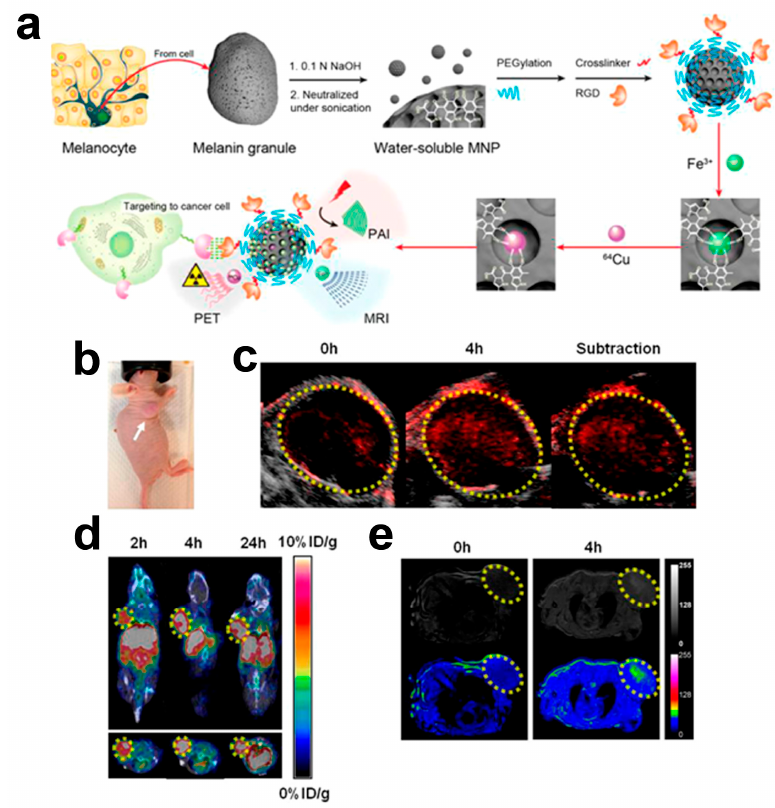
Figure 4. ( a ) Schematic illustration of the synthesis of the multimodality melanin nanoparticles (MNP). After PEG surface-modification, RGD peptides were further attached to the melanin-nanoparticles for tumor targeting. Then Fe 3+ and/or 64 Cu 2+ were chelated to the obtained MNPs for OA/MRI/PET multimodal imaging; in vivo multimodality imaging in U87MG tumor-bearing mouse: ( b ) photographic image (white arrow refers to the tumor position); ( c ) overlaying of ultrasonic (gray) and optoacoustic (red) imaging; ( d ) overlaying of decay-corrected coronal (top) and transaxial (bottom) small animal CT (gray) and PET (color) images; ( e ) MRI images (top row shows black and white images, and bottom row shows the pseudocolored images) after tail vein injection 64 Cu-Fe-RGD-PEG-MNP (tumor region is enveloped by yellow dotted line). Reprinted with permission from the reference [33], Copyright 2014, American Chemical Society.